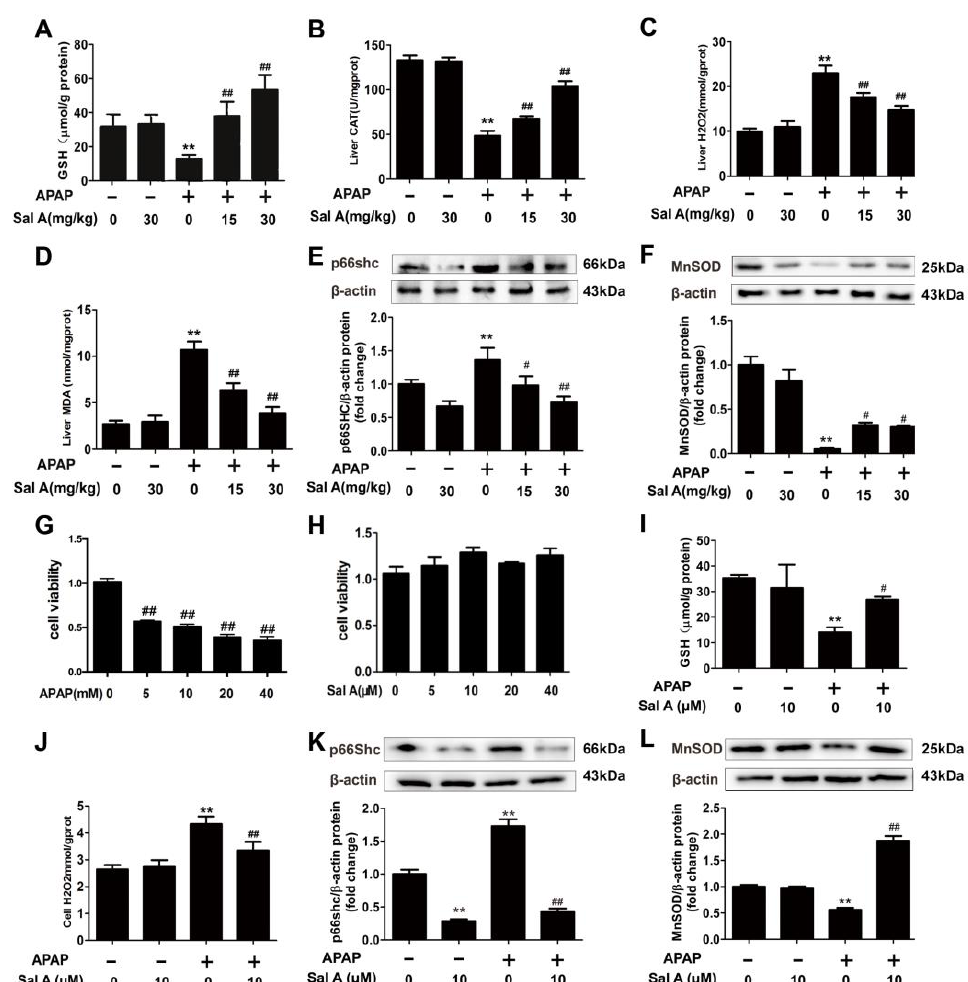
Figure 2. Sal A ameliorates hepatic oxidative stress in vivo and in vitro. ( A – F ) Sal A pretreatment was performed for 3 days followed by APAP stimulation in mice. ( A – D ) GSH, CAT, H 2 O 2 and MDA levels in mice, n = 8. ( E , F ) p66Shc and MnSOD protein expression in mice, n = 3. ( G ) AML12 cells were exposed to different concentrations of APAP (0, 5, 10, 20 and 40 mM) for 24 h. Cell viability, n = 8. ( H ) AML12 cells were exposed to Sal A for 24 h at different concentrations of 0, 5, 10, 20 and 40 µ M. Cell viability, n = 8. ( I – L ) AML12 cells were incubated with Sal A before exposure to APAP. ( I , J ) GSH and H 2 O 2 levels in AML12 cells, n = 8. ( K , L ) p66Shc and MnSOD protein expression in AML12 cells, n = 3. ** p < 0.01 vs. control. # p < 0.05, ## p < 0.01 vs. APAP.